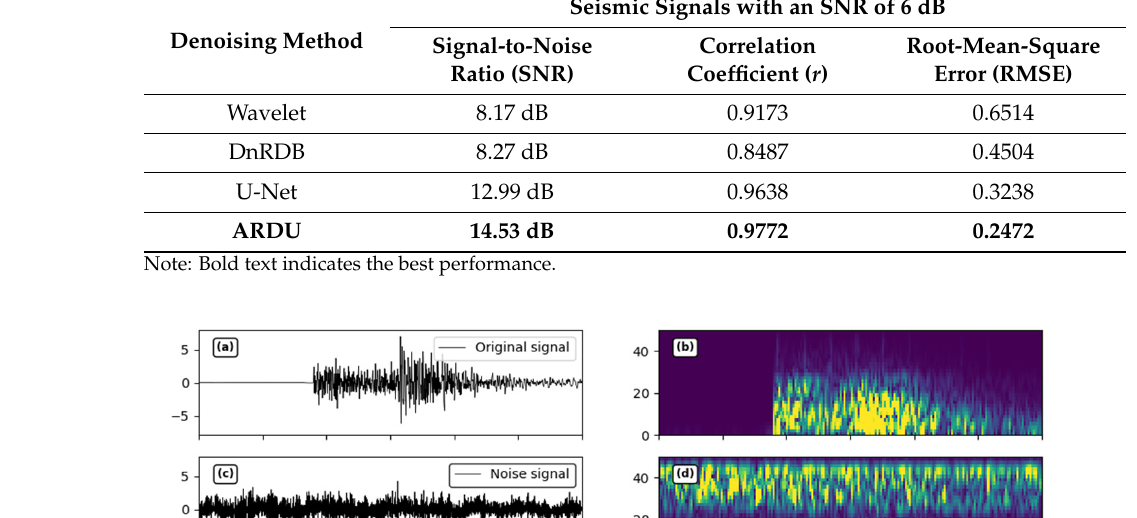
Table 2. Denoising results of seismic signals with an SNR of 0 dB using different methods.